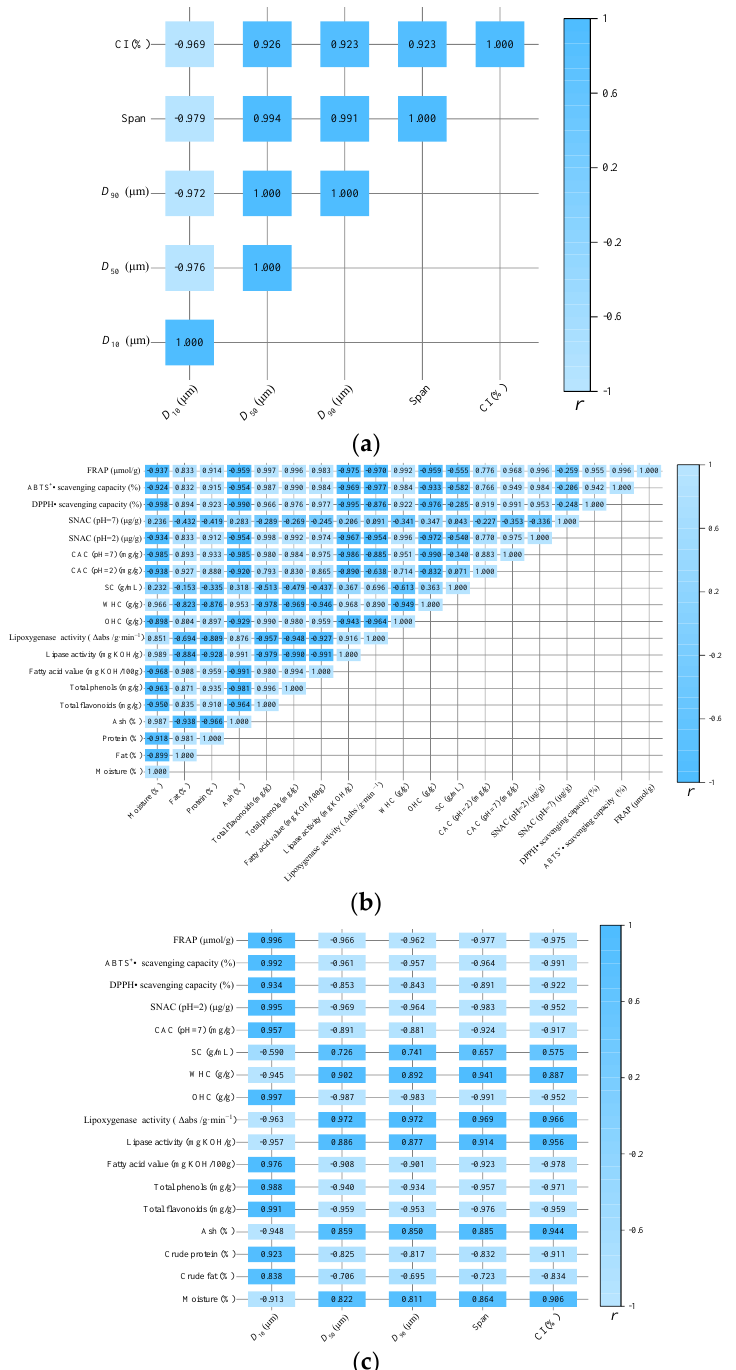
Figure 11. Heatmap of correlation analysis: ( a ) correlation analysis between structural properties; ( b ) correlation analysis among chemical composition, functional properties, and antioxidant properties; and ( c ) correlation analysis between structural properties and chemical composition, functional properties, and antioxidant properties. r is the correlation coefficient.